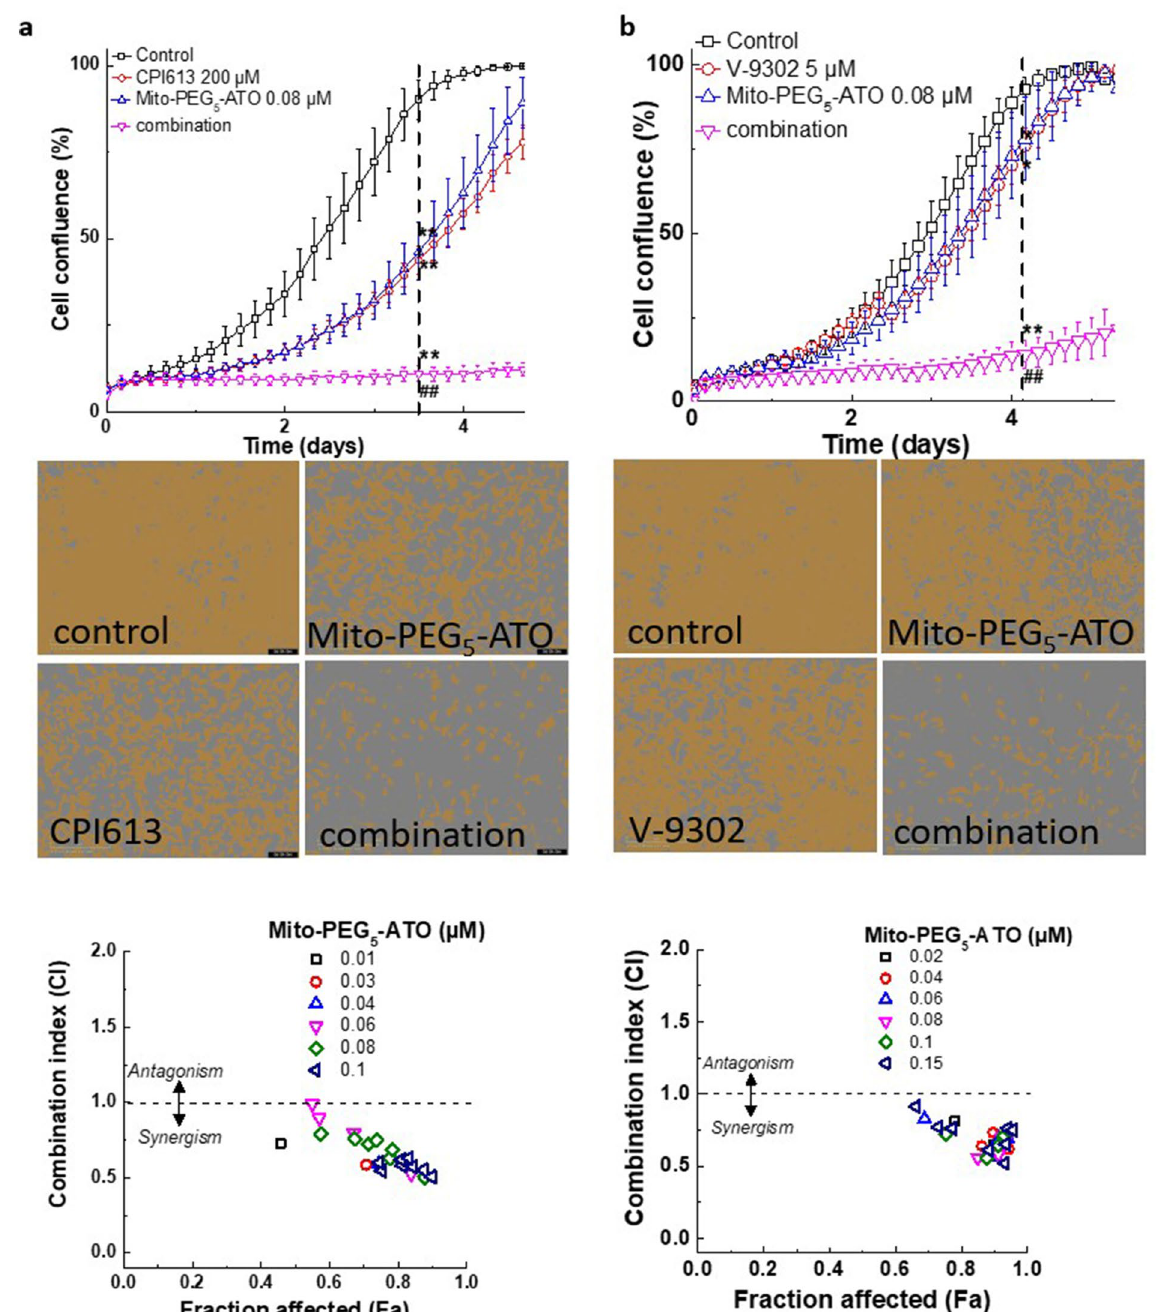
Figure 6. Synergistic inhibition of cell proliferation by Mito-PEG 5 -ATO and CPI-613 or V-9302 in MiaPaCa-2 cells. (Top) MiaPaCa-2 cells were treated with Mito-PEG 5 -ATO and CPI-613 ( a ) or V-9302 ( b ) independently and together at the indicated concentrations, and cell growth was monitored continuously. Data shown are the mean ± SD (n = 5). (Middle) Representative cell images are shown as a segmentation mask illustrated in brown when control cells reached ~ 90% confluence (vertical dashed line). ** p < 0.01 vs control. ## p < 0.01 vs Mito-PEG 5 -ATO or AZD-3965 alone. (Bottom) Cell confluence (control cells reached ~ 90% confluence) is plotted against concentration for the synergistic calculation. Bottom panels (a, CPI-613; b, V-913) show the combination index–fraction affected plots. The fraction affected parameter is used as a measure of the efficiency of the drug(s), with a value of 0 indicating complete inhibition of cell confluence and a value of 1 indicating the lack of effect on cell confluence. Data shown are the mean ±